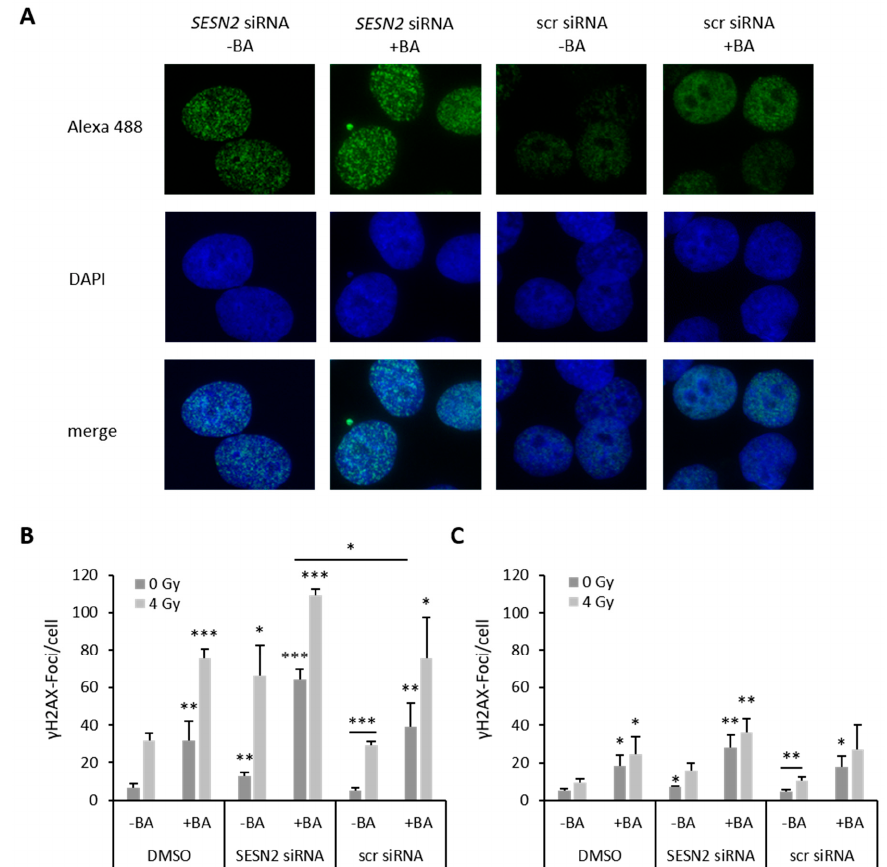
Figure 8. SESN2 silencing enhances DNA damage of BA ‐ treated breast cancer cells. ( A ) Representa ‐ tive immunofluorescence staining of γ H2AX foci (green) and cell nuclei (DAPI: blue) of non ‐ irradi ‐ ated MDA ‐ MB ‐ 231 cells. Breast cancer cell lines MDA ‐ MB ‐ 231 ( B ) and HS578T ( C ) were transfected with siRNA against SESN2, treated with BA and irradiated with 4 Gy under hypoxic conditions (0.1 % O 2 ). γ H2AX foci per cell were counted out of 100 cells. Data represent mean values (+SD) of at least three independent experiments. All data were referred to scr siRNA without BA treatment of non ‐ irradiated (0 Gy) or irradiated cells (4 Gy). Significant p values are highlighted with asterisks (* p ≤ 0.05; ** p ≤ 0.01; *** p = 0.001).